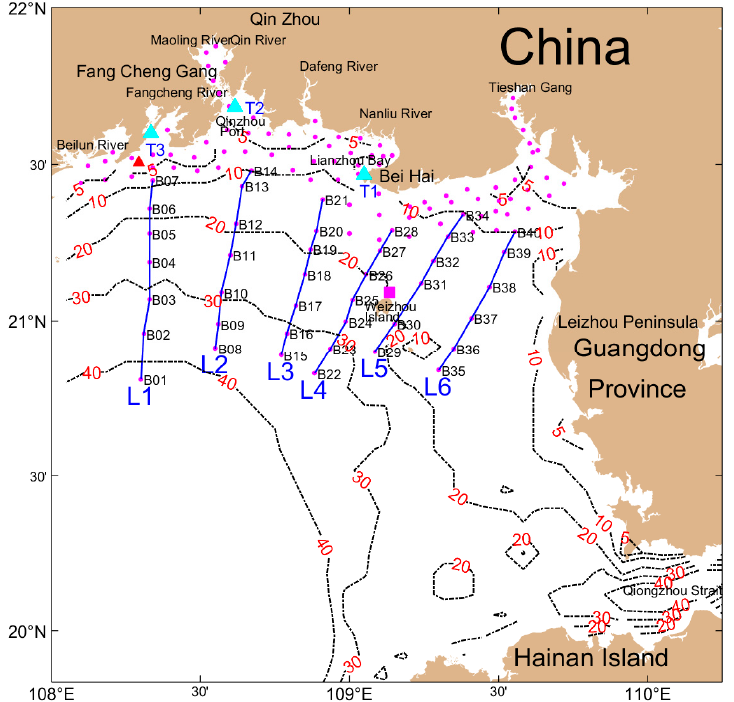
Figure 1. Distribution map of survey stations. The black dotted line is the water depth, the cyan triangle is tide level station, and T1, T2, and T3 is the Beihai Station, Qinzhou Station, and Fangchenggang Station, respectively; The magenta square is the seabed base station; The purple circle is survey station.